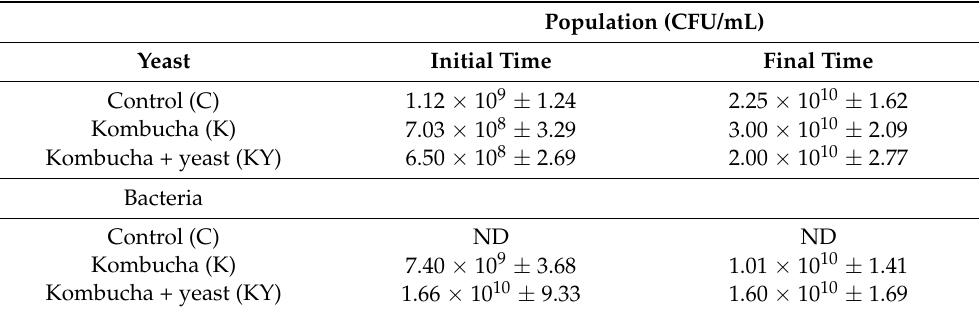
Table 2. Viable counts of yeast and mesophilic bacteria evaluated at the initial and final fermentations times in the three different